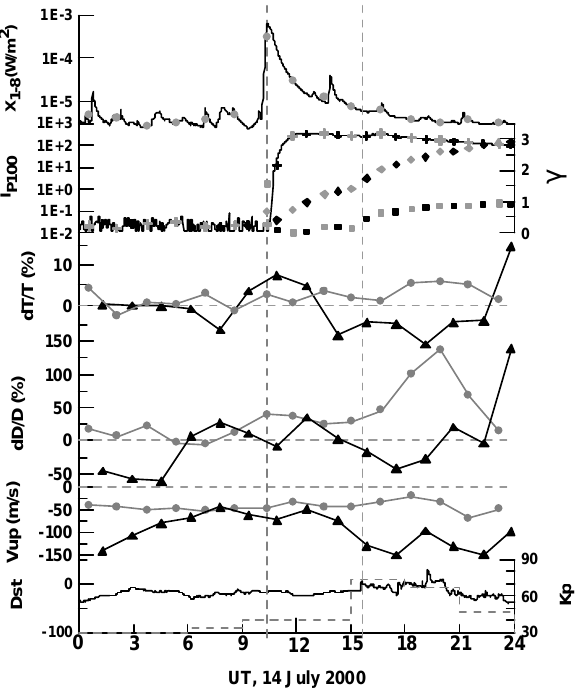
Fig. 4. An adjustment of three ROCSAT-1 orbits on 27 October Figure 4. An adjustment of three ROCSAT-1 orbits on October 27 (gray dotted lines, 3 min (gray dotted lines, 3-min time delay), 28 (solid lines, no delay) and Fig. 5. Topside ionosphere response to the solar event on 14 July 29 (gray dashed lines, –4 min time delay). The panels indicate (from time delay), 28 (solid lines, no delay) and 29 (gray dashed lines, -4 min time delay). The 2000 (from top to bottom): solar 1–8 ˚A X-ray emission and its ∼ 45- top to bottom): the satellite geographic location, altitude, local time, Figure 5. Topside ionosphere response to the solar event on July 14, 2000 (from top to min averages (circles); integral flux I P 100 of the SEP with ener- measured ion density and temperature in log scale, and vertical ion panels indicate (from top to bottom): the satellite geographic location, altitude, local time, bottom): solar 1-8 Å X-ray emission and its ~45 min averages (circles); integral flux I P100 of gies > 100MeV (solid line), its ∼ 45-min averages (crosses), and drift velocity. The ionospheric conditions for different passes are average spectral indices γ 60 (diamonds) and γ 10 (squares); relative much different, despite their spatial location is very close. measured ion density and temperature in log scale, and vertical ion drift velocity. The the SEP with energies >100 MeV (solid line), its ~45 min averages (crosses), and average changes of the ion temperature dT/T and density dD/D ; vertical spectral indices g 60 (diamonds) and g 10 (squares); relative changes of the ion temperature dT/T ion drift velocity V up ; geomagnetic indices Kp (dashed histogram, ionospheric conditions for different passes are much different, despite their spatial location is right axis) and 1-min Dst (solid line). Gray and black symbols indi- and density dD/D; vertical ion drift velocity Vup; geomagnetic indices Kp (dashed histogram, cate ∼ 45-min averages calculated, respectively, for sunlit and night- very close. right axis) and 1-min Dst (solid line). Gray and black symbols indicate ~45 min averages side passes of the ROCSAT-1. Vertical dashed lines depict the solar flare at 10:20 UT and geomagnetic storm onset at 15:35 calculated, respectively, for sunlit and nightside passes of the ROCSAT-1. Vertical dashed lines depict the solar flare at 1020 UT and geomagnetic storm onset at 1535 UT.